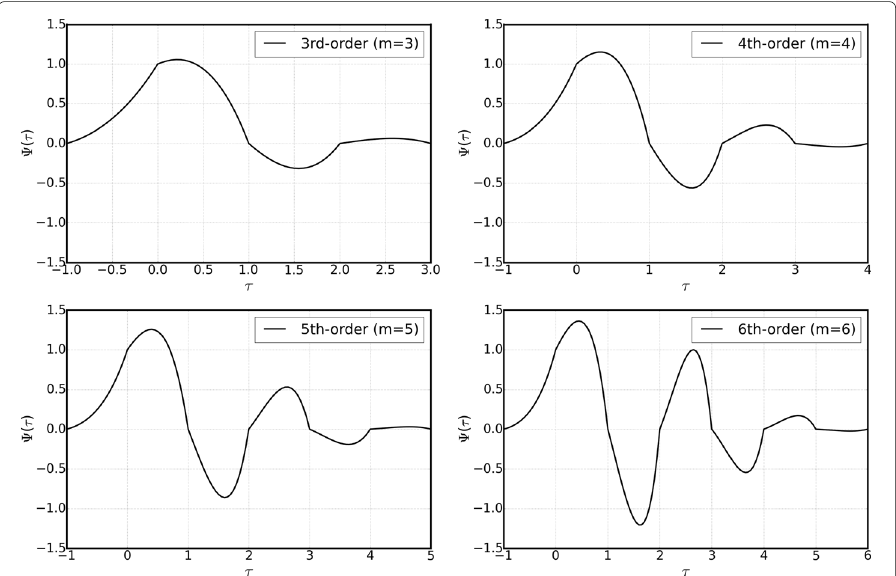
Fig. 1 τ -normalized basis function for the 3rd- to 6-th order Lagrange basis functions as defined in (11). Here )/(cid:4) t with respect to temporal node t τ = ( t − t j